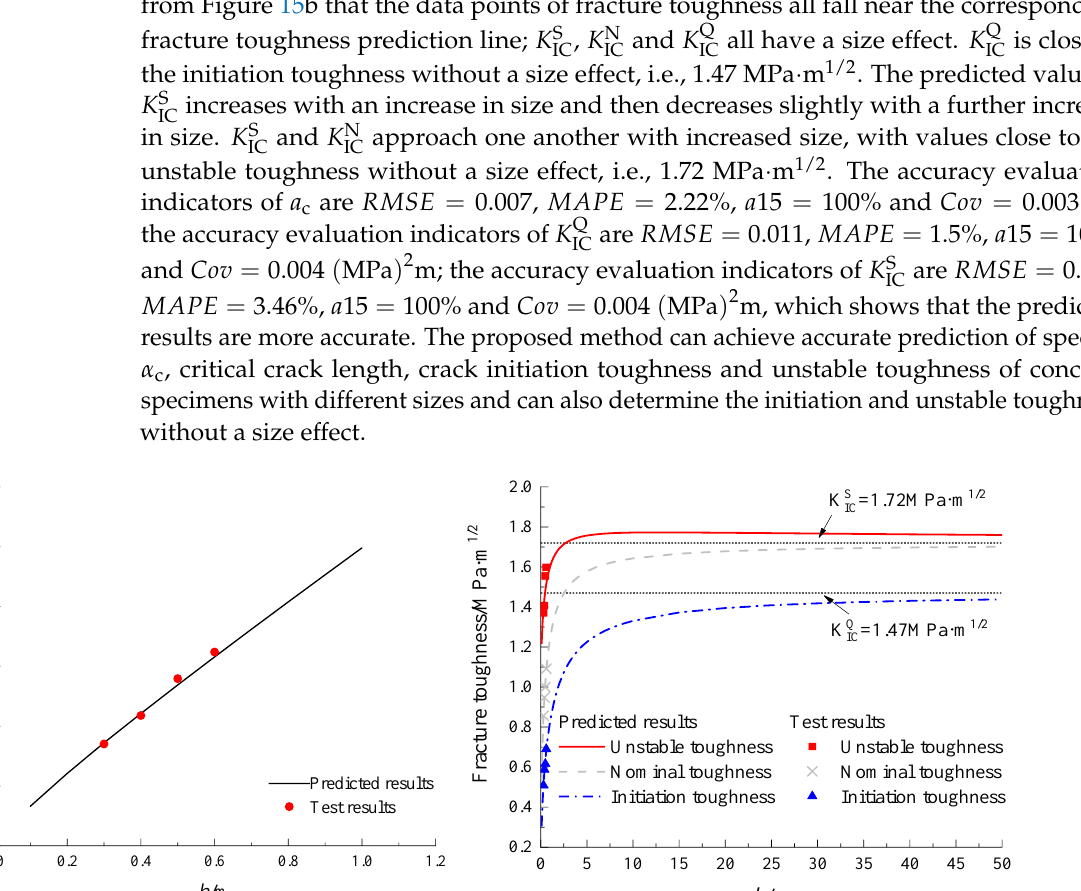
Table 3. Fracture test results reported in reference [57].